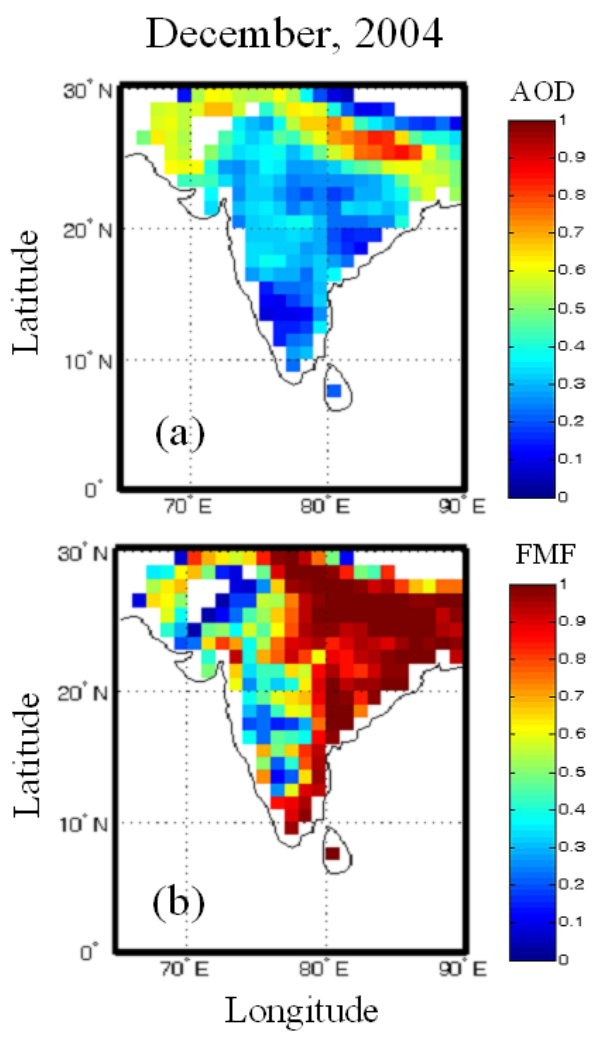
Fig. 2. Mean spatial distribution of MODIS derived AOD at 550nm (a) and fine mode fraction (b) during December